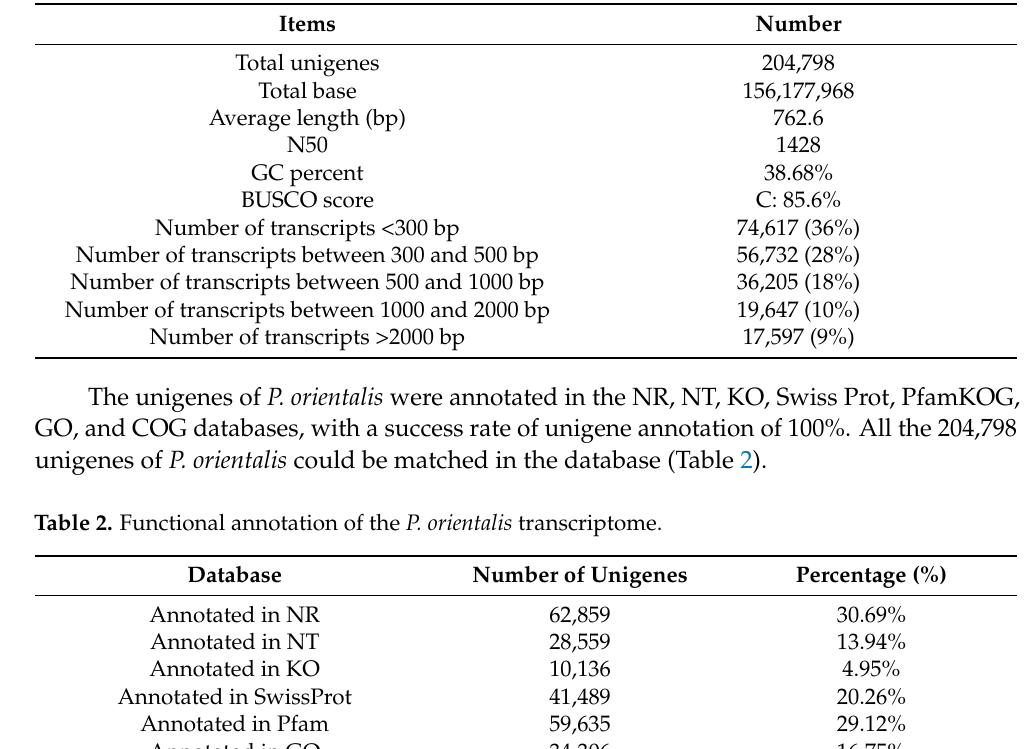
Table 1. De novo assembly of the P. orientalis transcriptome.